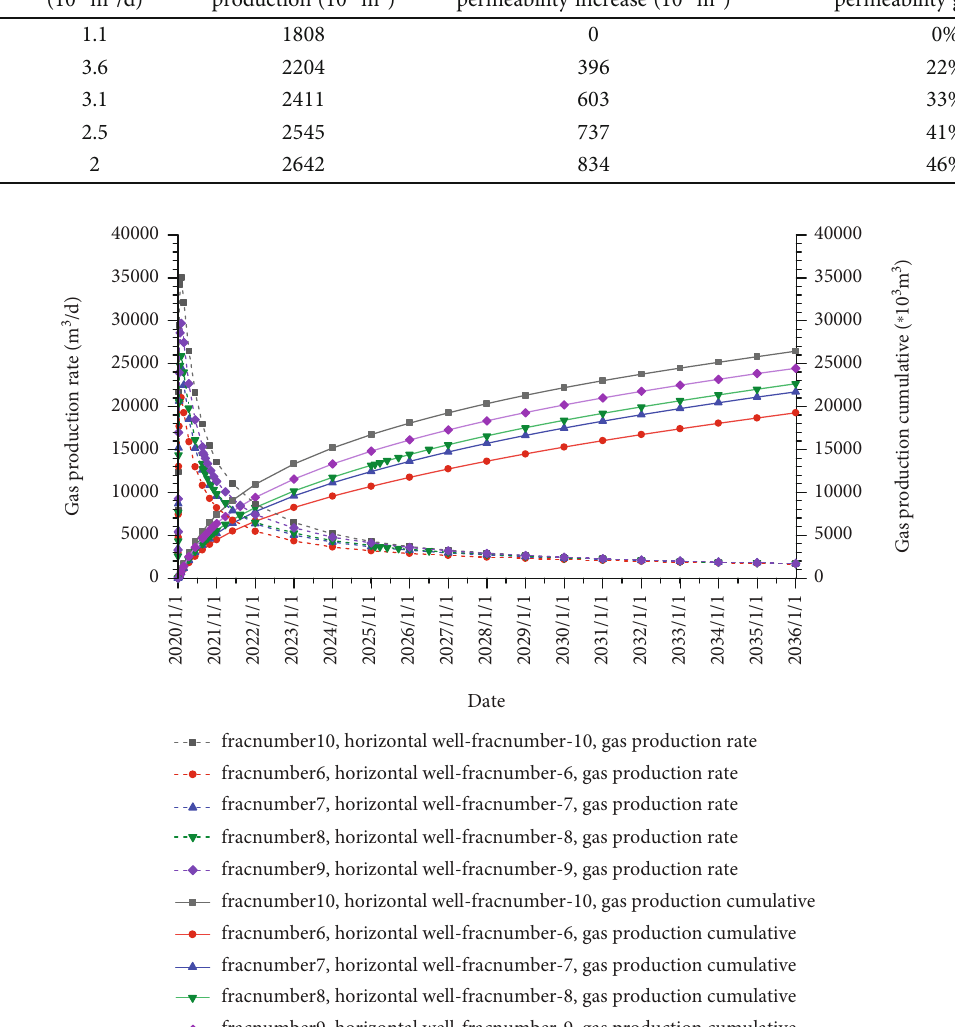
Figure 7: Horizontal well gas production under di ff erent fracture